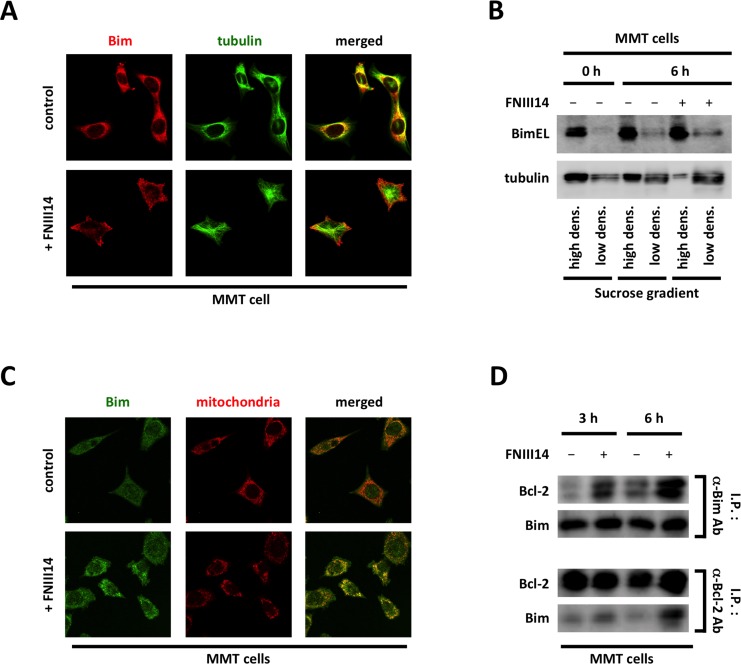
Activation of Bim signaling pathway in mammary tumor cells with FNIII14 treatment.(A) MMT cells were seeded on fibronectin-coated cover-slips and stimulated with peptide FNIII14. Then, immunofluoro-staining, using anti-Bim (red) and anti-tubulin (green) Abs, was performed and these samples were analyzed by confocal microscopy. Representative images from three independent experiments are shown. (B) Whole cell lysate of MMT cells with FNIII14 treatment was divided into a high-density and a low-density fraction by sucrose gradient centrifugation, and both fractioned samples were subjected to western blotting analysis with anti-Bim Ab and anti-tubulin Ab. (C) MMT cells were seeded on fibronectin-coated cover-slips and stimulated with peptide FNIII14 for 18 hrs. Then, immunofluoro-staining, using anti-Bim Ab (green) and mito-tracker (red), was performed and these samples were analyzed by confocal microscopy. Representative images from three independent experiments are shown. (D) Bcl-2 binding proteins and Bim binding proteins were immunoprecipitated from whole cell lysate of FNIII14-treated MMT cells using anti-Bcl-2 Ab and anti-Bim Ab, Precipitated proteins were subjected to western blotting analysis using anti-Bim Ab and anti-Bcl-2 Ab,